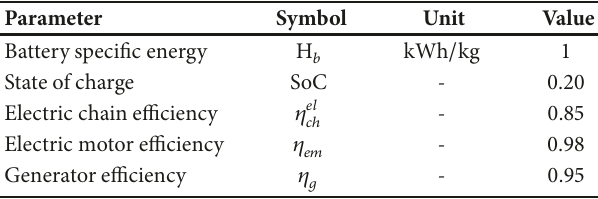
Table 2: Hybrid electric chain relevant